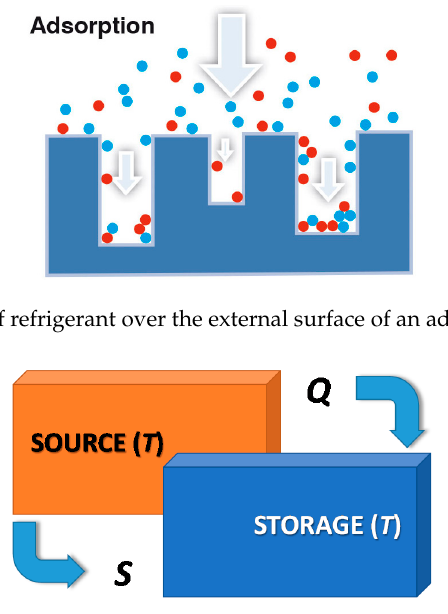
Figure 3. Direct heat storage, charging phase.